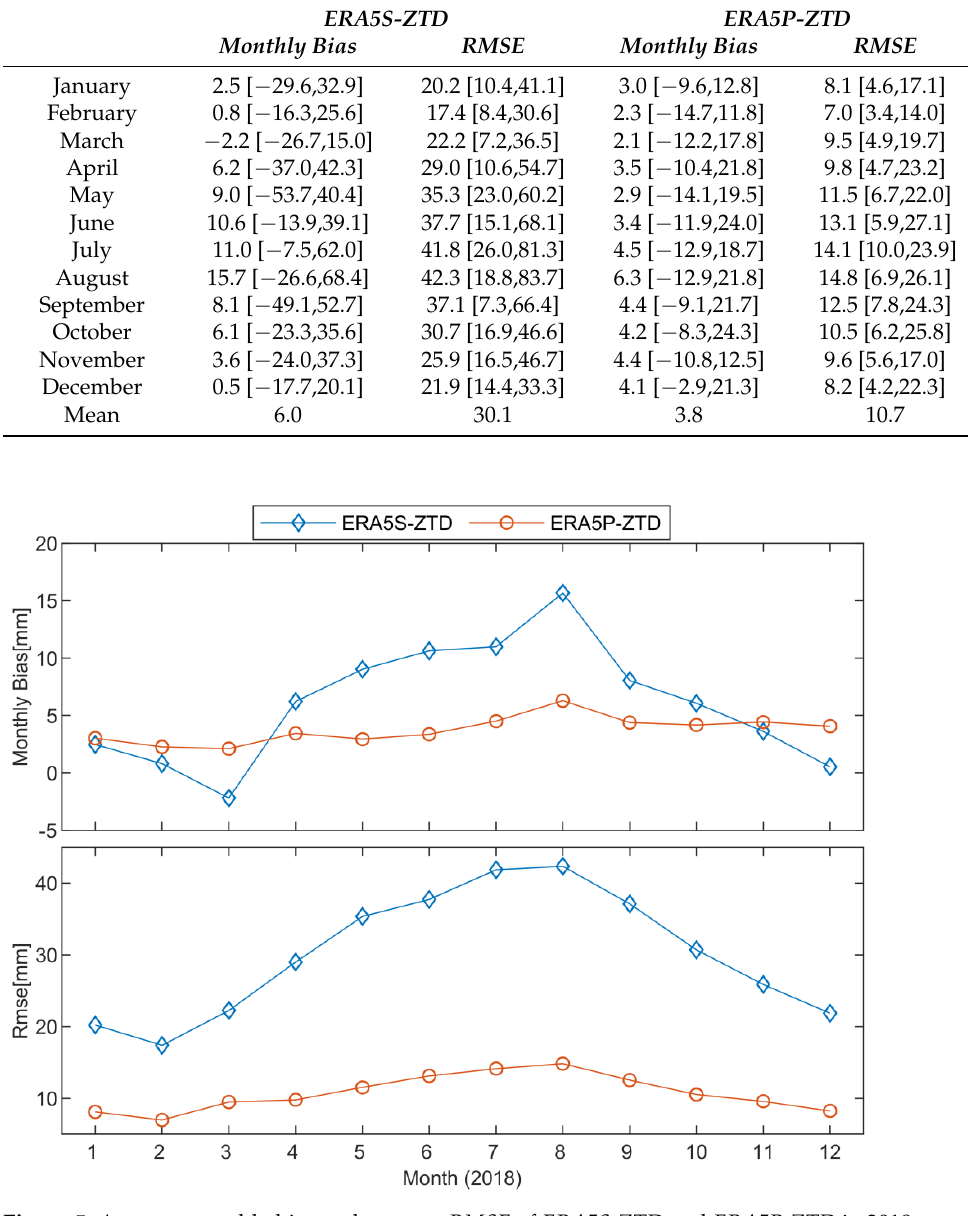
Figure 5. Average monthly bias and average RMSE of ERA5S-ZTD and ERA5P-ZTD in 2018.